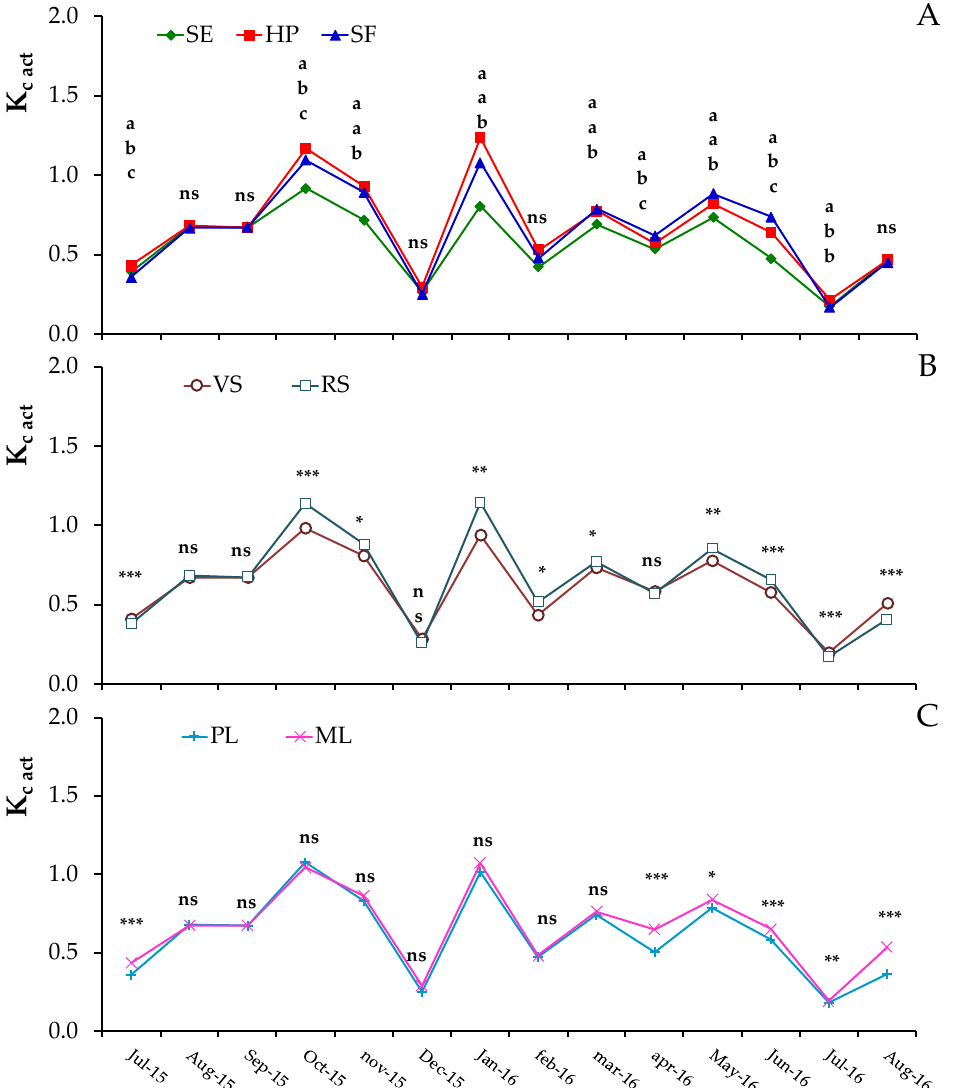
Figure 10. Variation of the actual crop coefficient (K c act ) during the experiment as affected by plant mix ( A ), substrate ( B ), and drainage / storage layer ( C ). SE = Sedum mix, HP = herbaceous perennials, SF = su ff ruticose, VS = volcanic substrate, RS = recycled crushed brick substrate, PL = preformed plastic drainage / storage layer, ML = mineral drainage / storage layer. On each date, values with di ff erent letters are significantly di ff erent according to Tukey’s HSD test ( p < 0.05). *, **, and *** = significant for p -values of < 0.05, < 0.01, and < 0.001 according to the analysis of variance (ANOVA). ns = not significant.